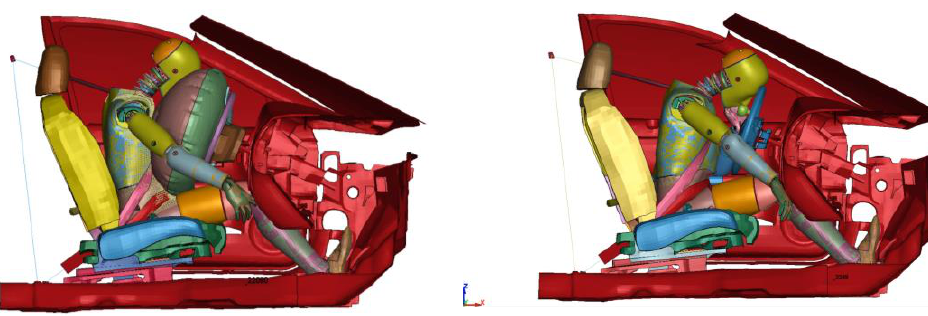
Figure 11. The investigated head injury cases for the impacts: head – airbag at 389 ms ( left ) and the head – steering wheel at 396 ms ( right ) after the start of the simulations.